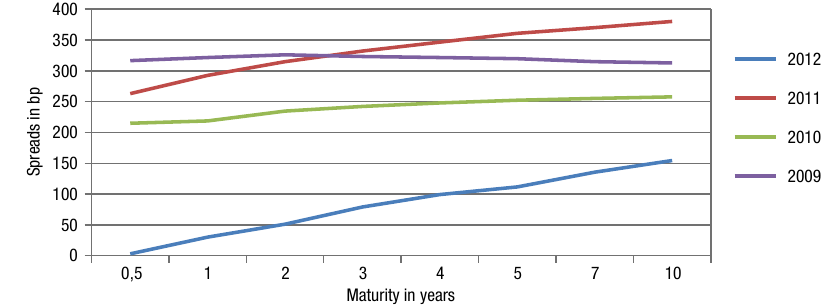
Fig. 3. Credit curve of Lithuanian CDS spreads in basis